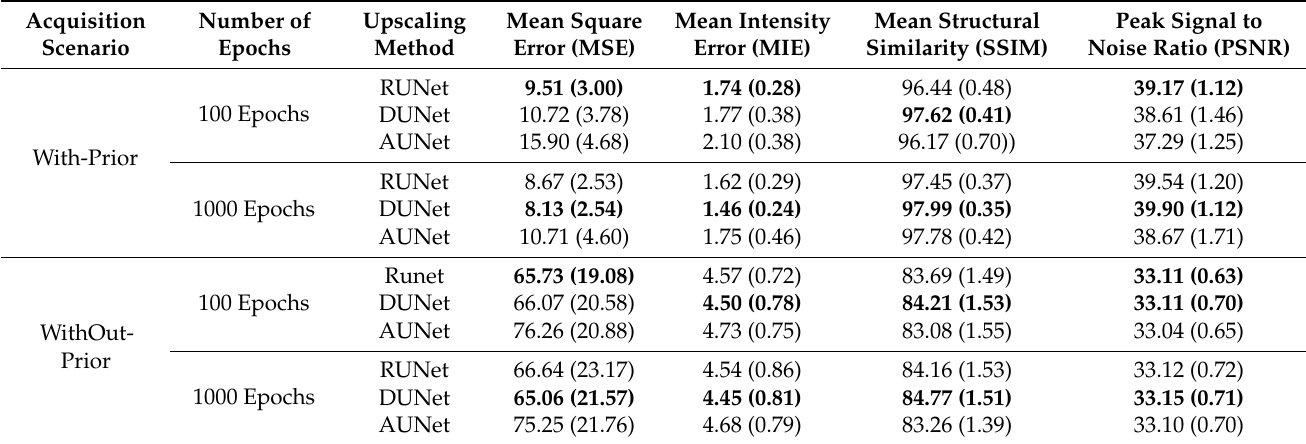
Table 1. Upscaling a 1/8 downsampled (22 × 26) synLQ with the three Unets. The best results are represented in bold. The numbers represent the mean value followed by the standard deviation in parenthesis.